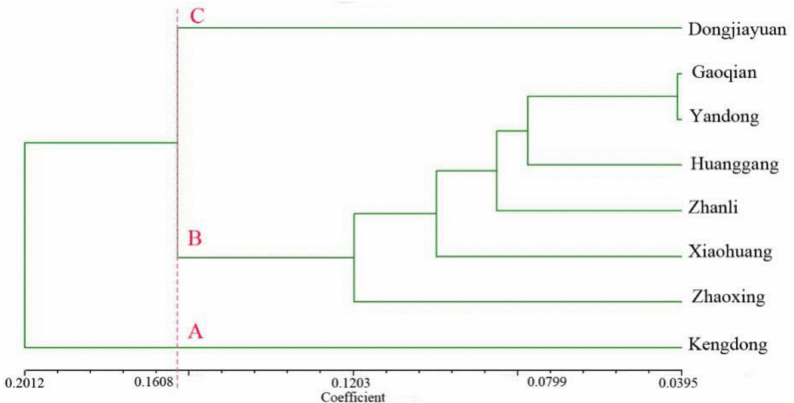
Figure 6. The genetic distance of different varities of Kam fragrant glutinous rice from eight Dong